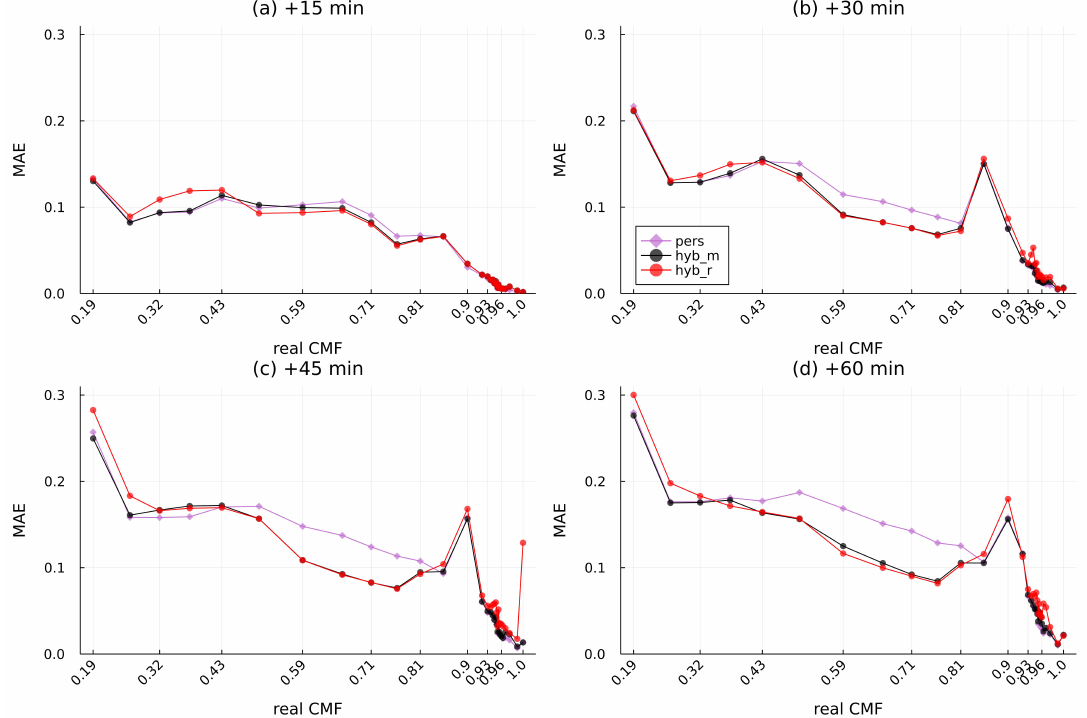
Figure A4. MAE for each CMF class for ( a ) 15 min, ( b ) 30 min, ( c ) 45 min, and ( d ) 60 min ahead in 2020 for